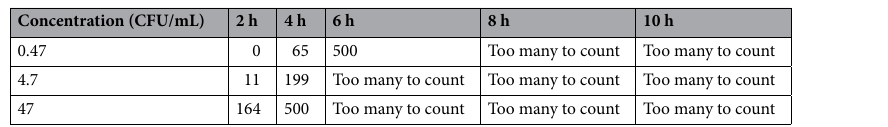
Table 3. Colony count at each time point of testing for Fig.